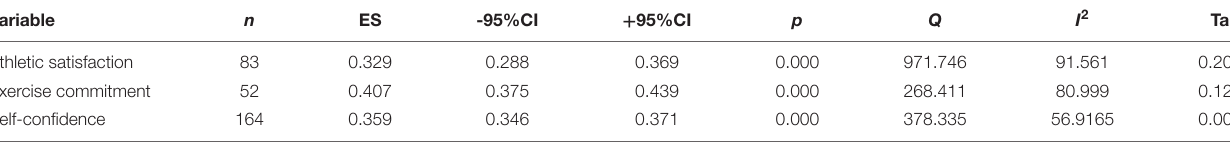
TABLE 2 | Overall effect size levels of self-management on psychological outcomes. Variable